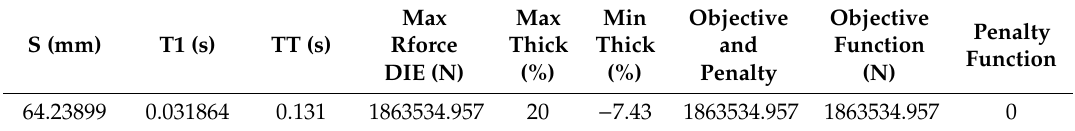
Table 9. Optimal combination of regression model for Blank1.